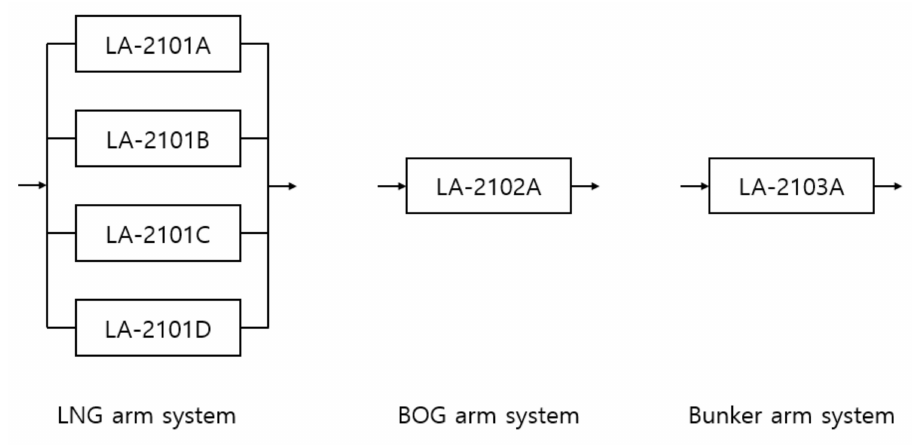
Figure 13. The parallel system of